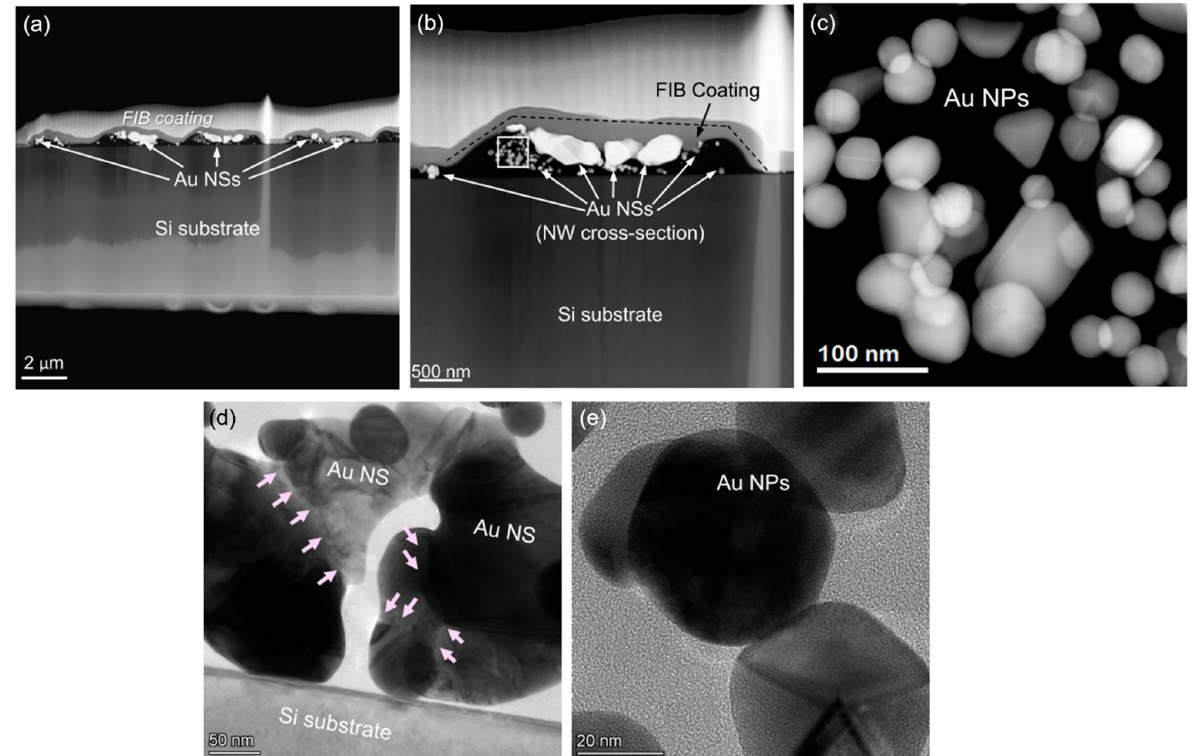
Figure 8. ( a – c ) HAADF and ( d , e ) HRTEM images of the cross-section of different AuNSs made with an LP = 100 mW and ET = 150 ms after TPA–DLW. These images illustrate the autocatalytic growth of the AuNSs after TPA–DLW, before the HAuCl 4 bath (see Figure 1d or Figure 5a). The duration of this growth is estimated as the lag between the TPA–DLW process and the washing step with deionized water (~10 s); AuNPs appear brighter than the background in the HAADF images ( a – c ) since the regions with heavier elements provide a more intense signal in this mode; ( b , d ) show that the AuNSs are physically deposited onto the Si substrate. Arrows in ( d ) indicate merging regions since TPA–DLW is able to create larger structures by the coalescence of smaller individual AuNPs. Different shapes of the individual AuNPs (decahedral, pentagonal bipyramid) are shown in ( c , e ).